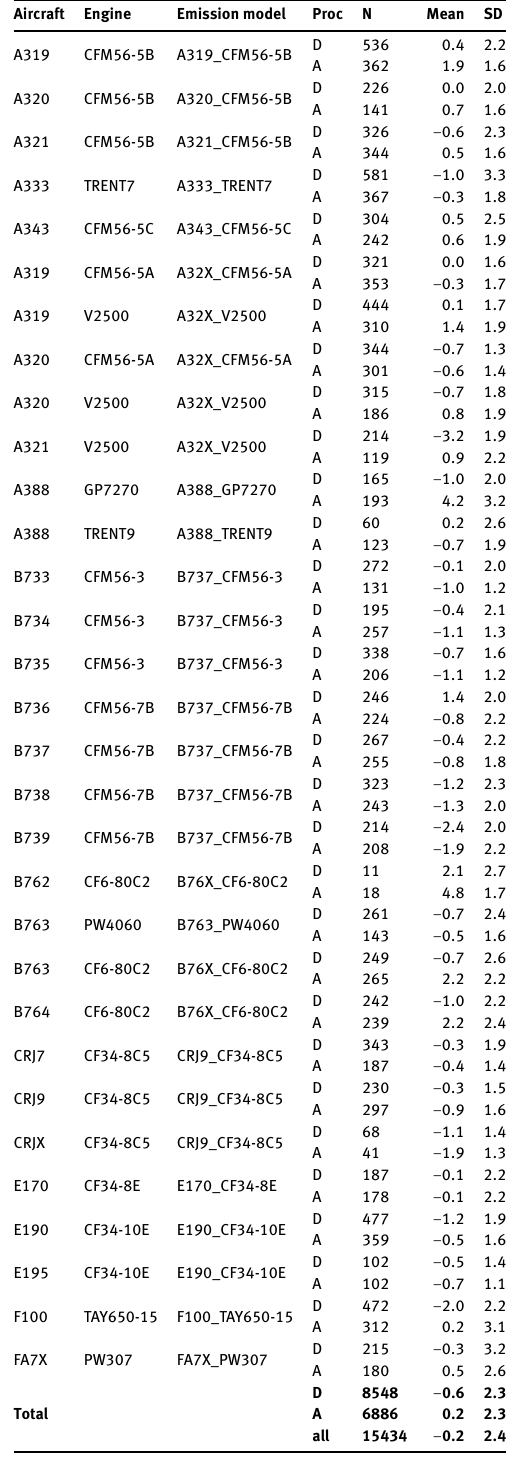
Table 2: Differences between simulation and measurements (ZRH and GVA combined) for all reduced models, separated into de- partures (D) and approaches (A). N: number of noise events; SD: standard deviation.